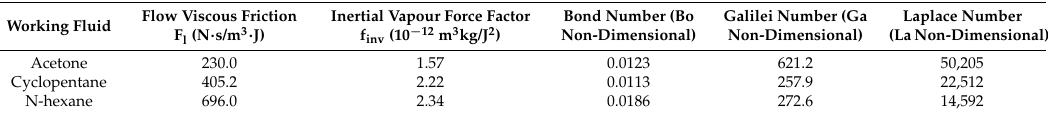
Table 3. The calculated parameters of selected working fluids using properties specified in Table 2. Working